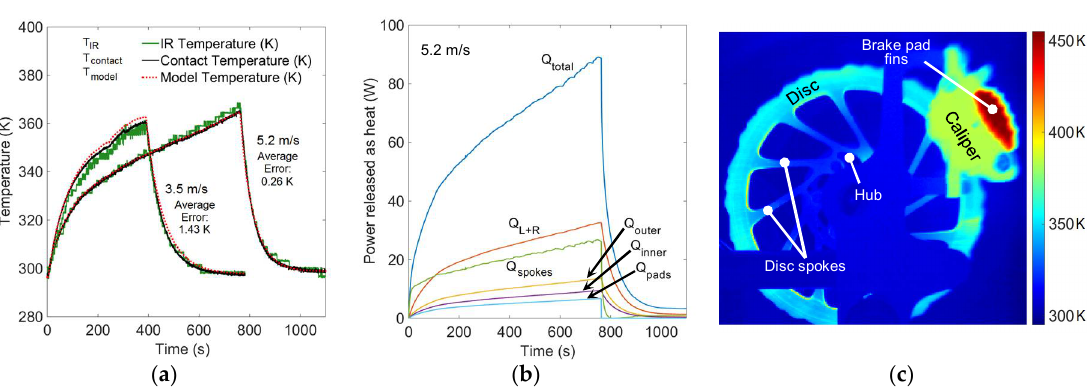
Figure 3. Numerical model and experimental results: ( a ) Comparison of model temperature prediction to experimental contact and IR non-contact thermometer temperatures for 3.5 and 5.2 m/s with total average errors ∫ (| (cid:1846) (cid:3040)(cid:3042)(cid:3031)(cid:3032)(cid:3039) − (cid:1846) (cid:3030)(cid:3042)(cid:3041)(cid:3047)(cid:3028)(cid:3030)(cid:3047) |) (cid:1856)(cid:1872)/ (cid:1872) (cid:3047)(cid:3042)(cid:3047)(cid:3028)(cid:3039) between the model and contact temperatures indicated; ( b ) Model predicted heat release from each surface for 5.2 m/s; ( c ) Infrared thermography image during heating, with disc model temperature at 356 K and emissivity set to 0.19, i.e., the same emissivity applied to the IR non-contact thermometer data shown to the